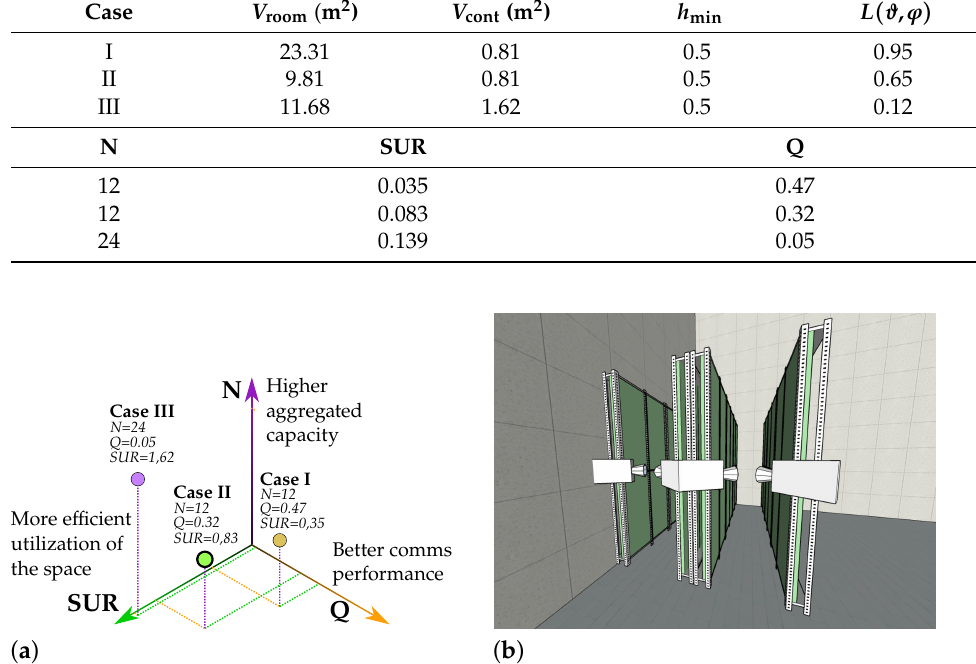
Figure 7. Illustration of the results of the plant distribution study. ( a ) Space generated by the multidimensional metric F; ( b ) example of Case II’s replication